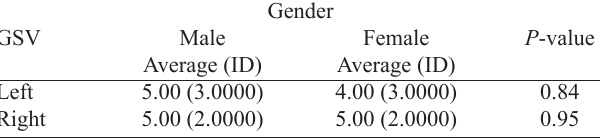
Table 2. Distribution of the valves in relation to sex.